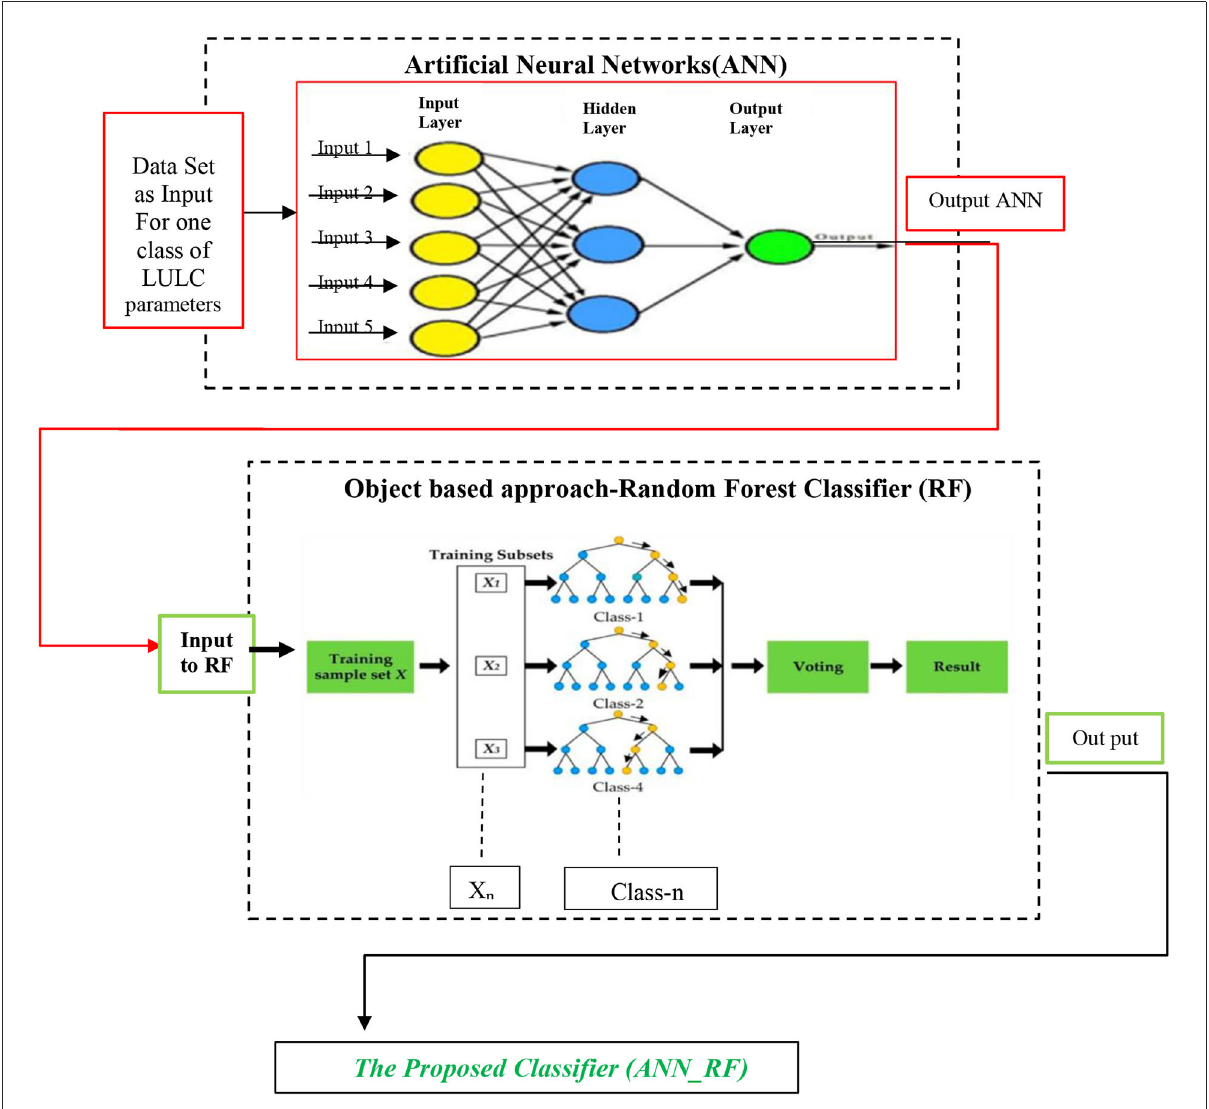
FIGURE1 A workflow diagram for proposed work hybrid artificial neural networks (ANN _